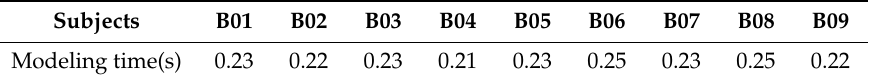
Table 3. Average modeling time for nine subjects.